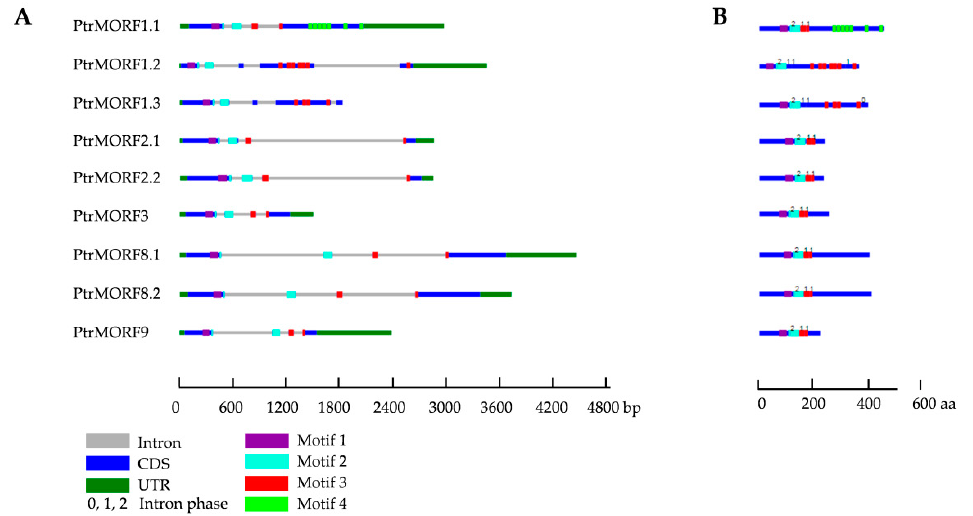
Figure 2. Gene structures of poplar MORF genes. ( A , B ) The gene structures of PtrMORF genes were built using GSDraw (http://wheat.pw.usda.gov/piece/GSDraw.php) by submitting both genomic sequences obtained from PopGenIE (http://popgenie.org/) and coding sequences (CDS) of PtrMORF genes.